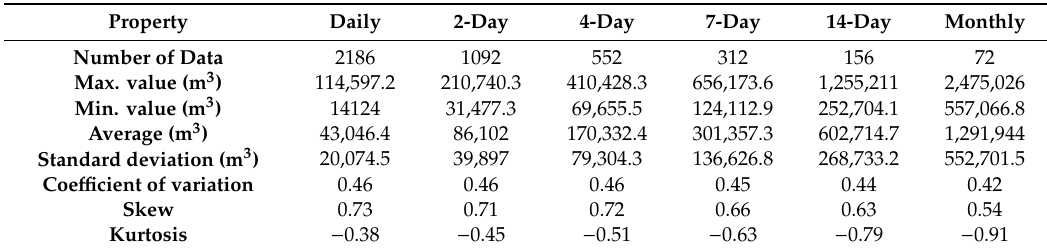
Table 1. Characteristics of the temporal water consumption values in test case in whole urban scale.